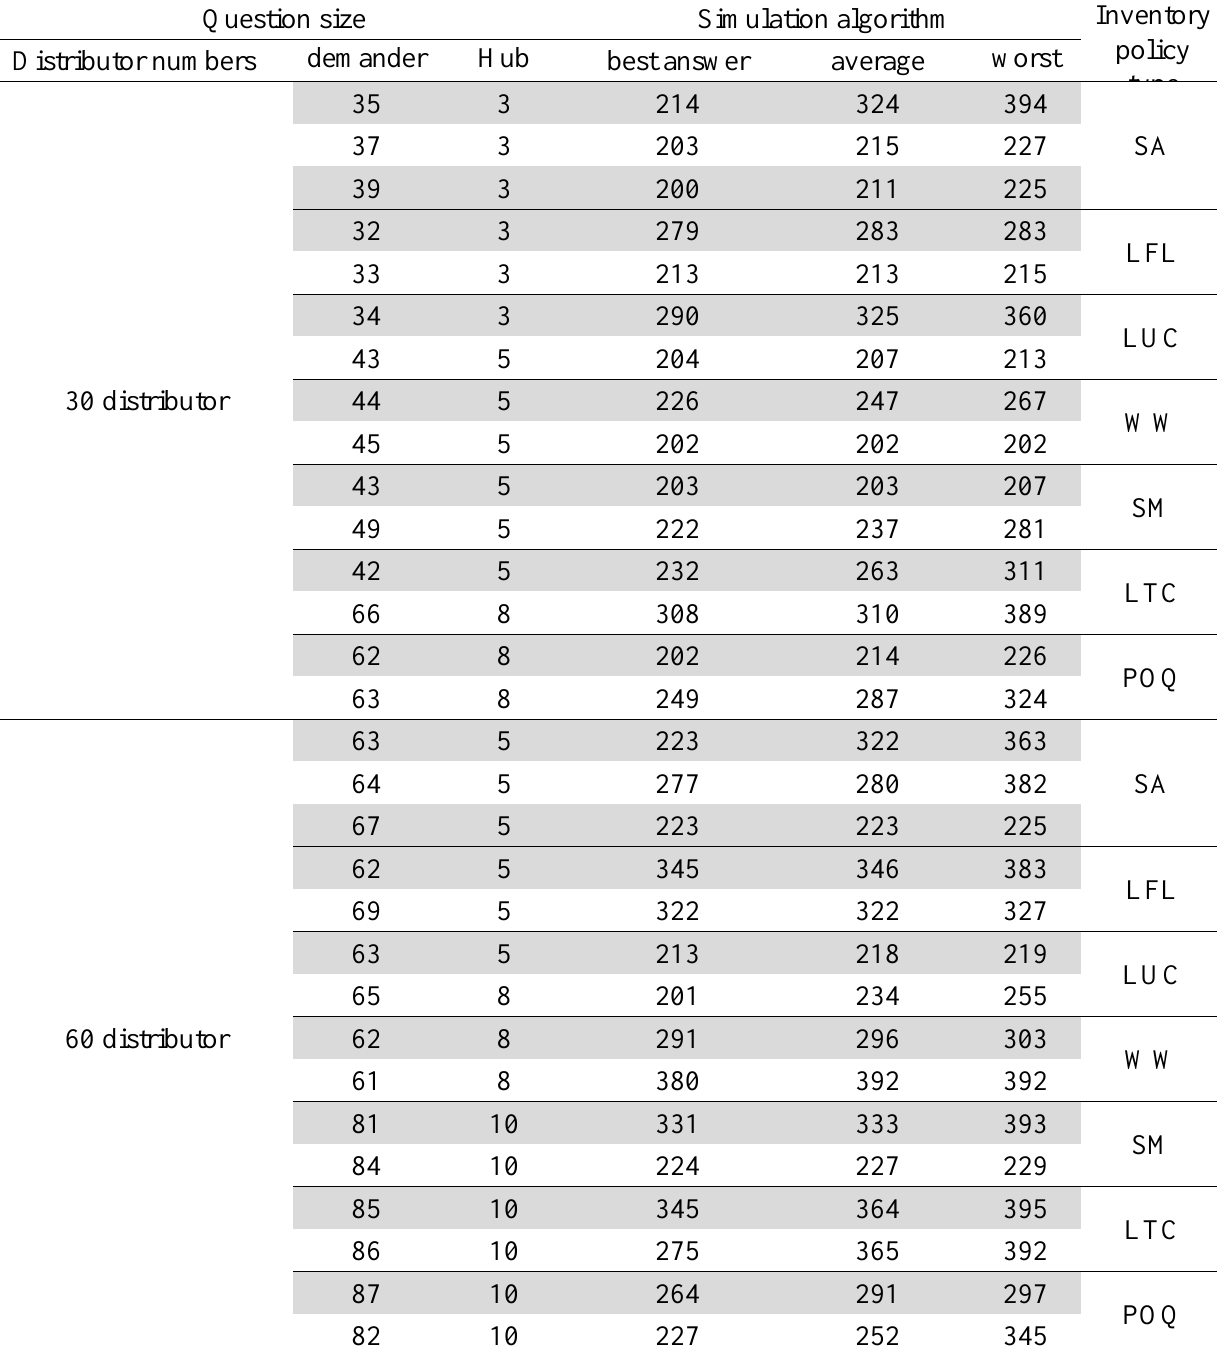
Table 5 Comparing the models in supply